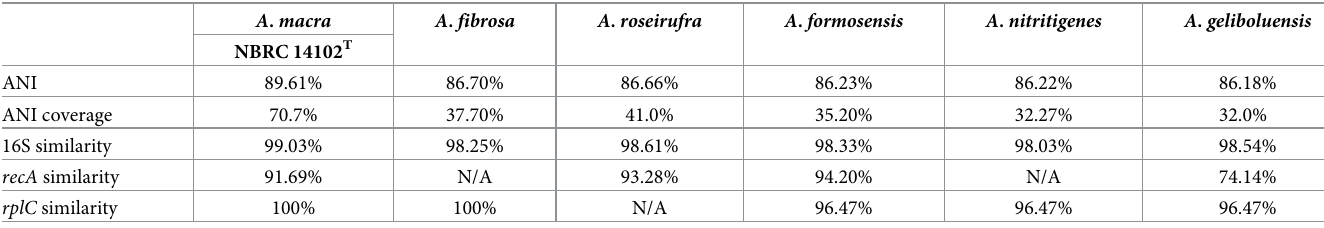
Table 1. Whole-genome comparison between Actinomadura sp. 32–07 and closely related Actinomadura species identified by TrueBac ™